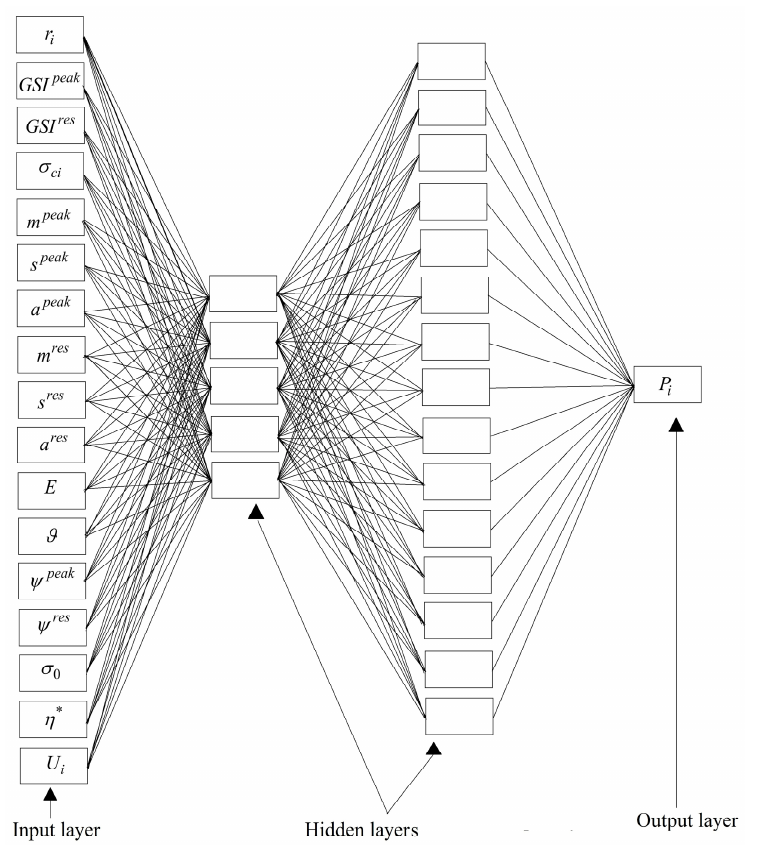
Figure 5. The topology of the optimum MLP-ANN (17-5-15-1) developed for the prediction of the P i (Hoek–Brown criterion).